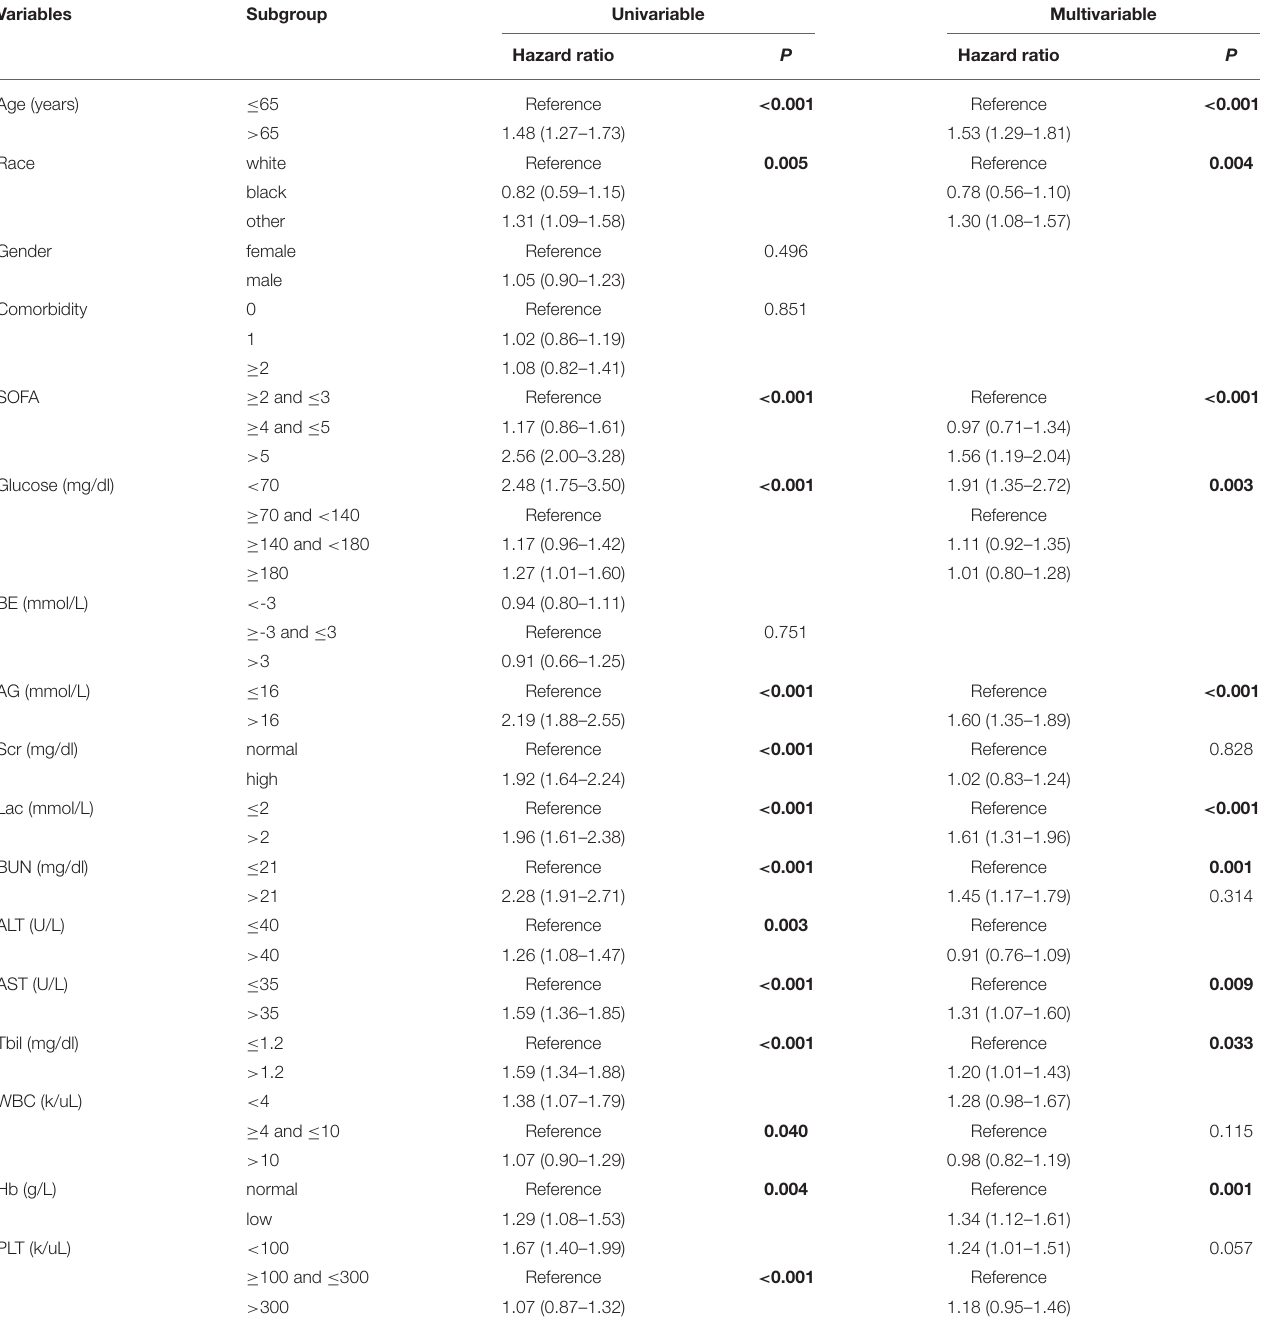
TABLE 4 | Univariate and multivariate Cox regression analyses of predictive variables correlated with 30-day mortality in septic patients without diabetes.